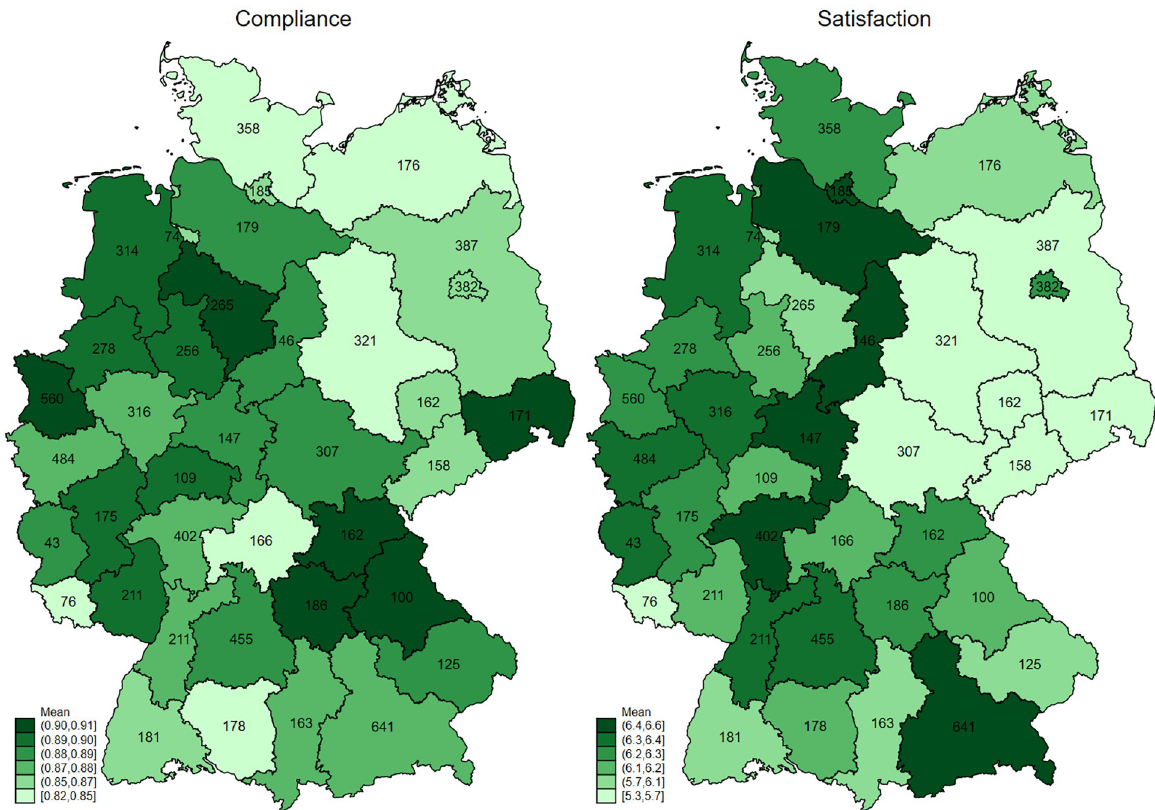
Fig 1. Distribution of compliance and satisfaction over NUTS-2 regions. Source: SOEP-CoV waves 1, 2 and SOEP-Core of Socio-Economic Panel (SOEP) (v37). The figure shows respondents’ mean values of compliance and satisfaction at the NUTS-2 region level. Compliance is calculated as the mean over 9 compliance components (dummy variables) as depicted in Fig 1 and ranges from 0 (does not comply with any measure) to 1 (complies with all measures). Satisfaction with the government’s COVID-19 crisis management ranges from 0 (low)—10 (high). The numbers on the map indicate the observation numbers, aggregated over wave 1 (2020) and wave 2 (2021). Over all NUTS-2 regions, observations add up to 9,210 (3,390 in wave 1 and 5,820 in wave 2), corresponding to the number of person-year observations in our main results Table 3.